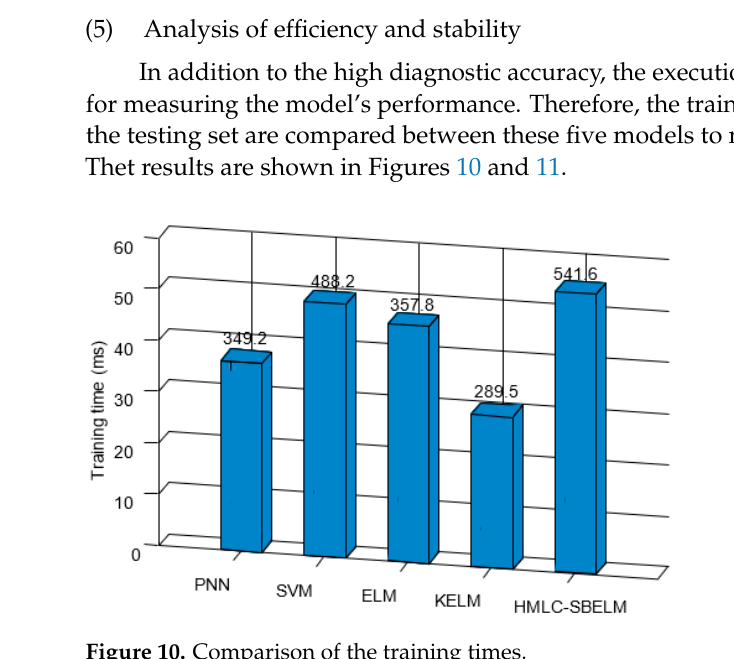
Figure 10. Comparison of the training times.